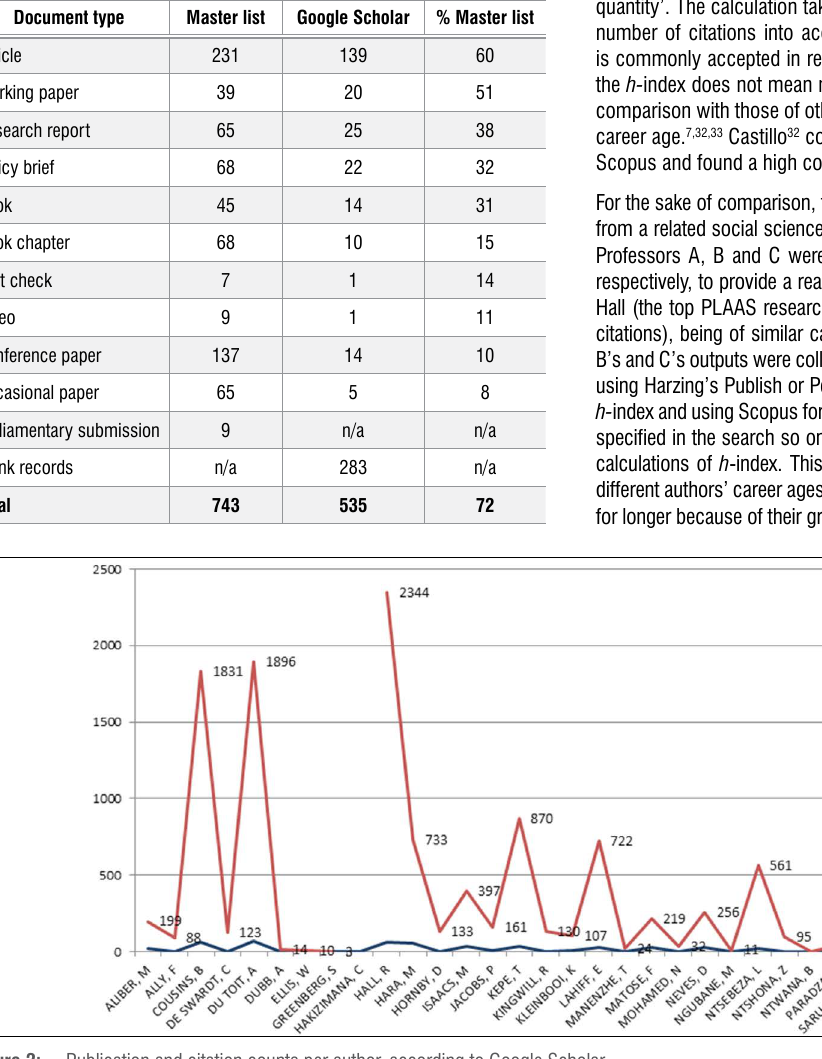
Figure 2: Publication and citation counts per author, according to Google